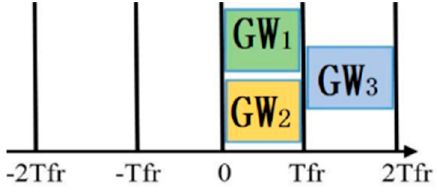
Figure 3. Slotted ALOHA. Table 1. Orthogonal combinations of SF and